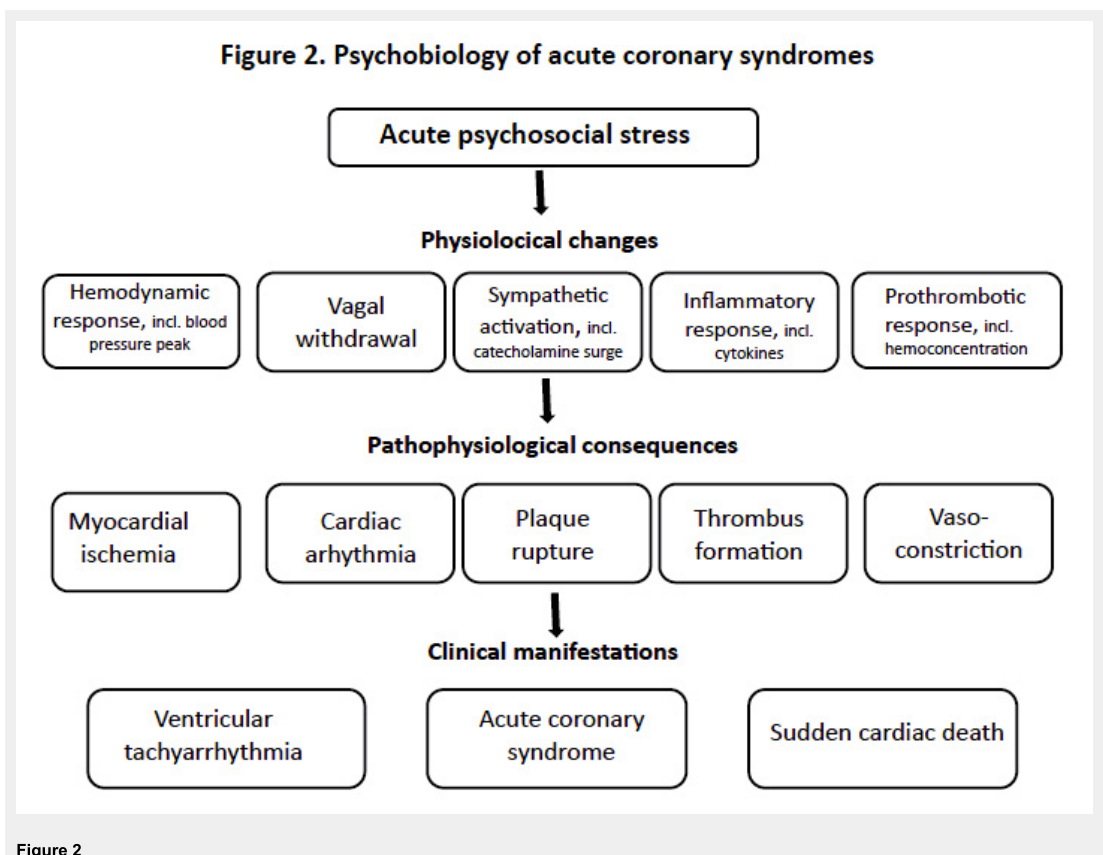
The scheme shows the cascade from physiological cardiovascular changes to pathophysiological alterations and eventually the clinical manifestation of cardiovascular disease in response to acute psychosocial